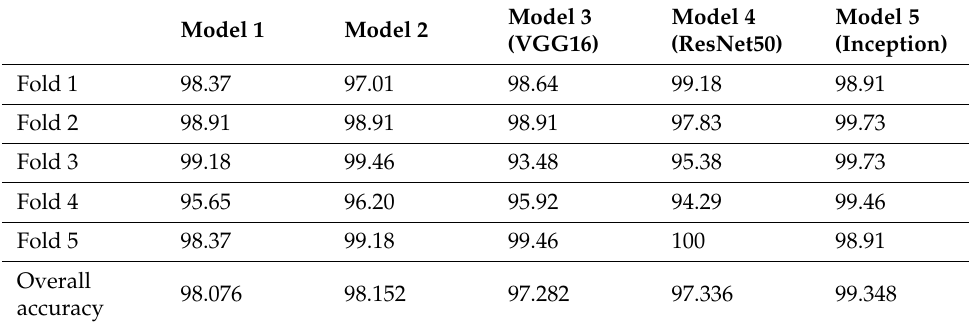
Table 1. Cross-validation accuracy across all models.